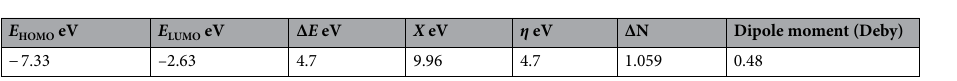
E HOMO eV E LUMO eV Δ E eV Χ eV η eV ΔN Dipole moment (Deby) − Table 5. Quantum chemical parameters of [DEMEMA][FSI].